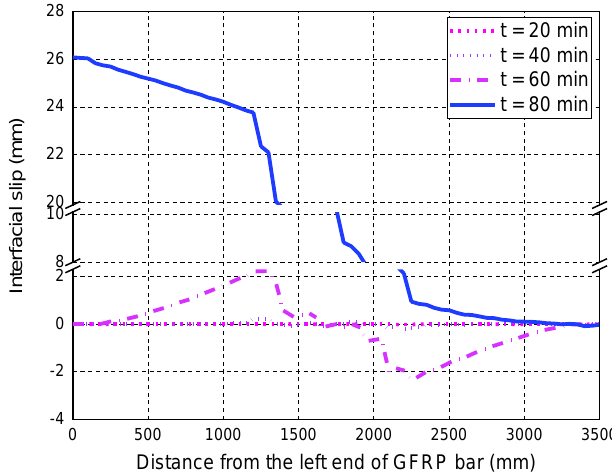
Figure 16. Interfacial slip distributions along the GFRP bar length of S3.